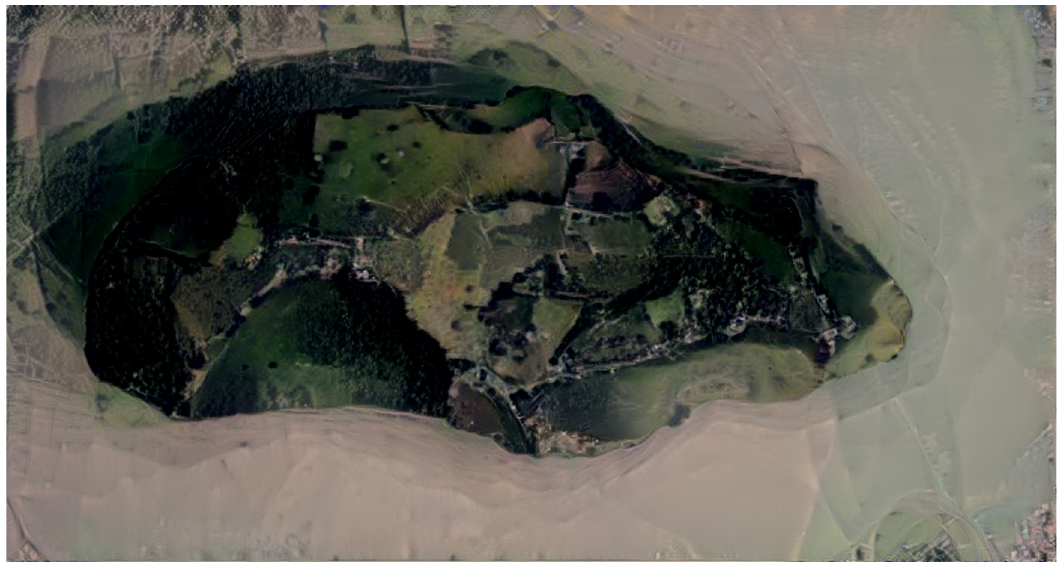
Figure 10: Track & Trace II , 2020 ( Di ff ractive Image – style transfer location setting satellite landscape image and detailed fl int RTI )